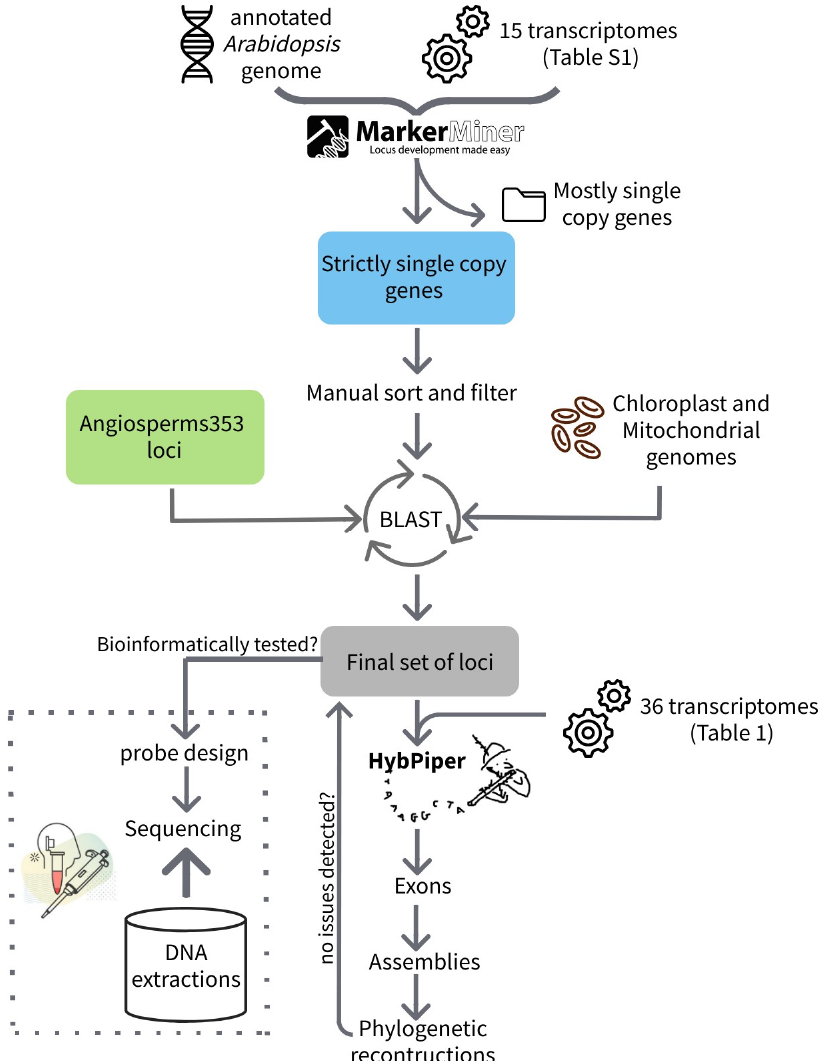
Figure 1. Flowchart of the pipeline with general steps and tools. For more details see the Methods Section.